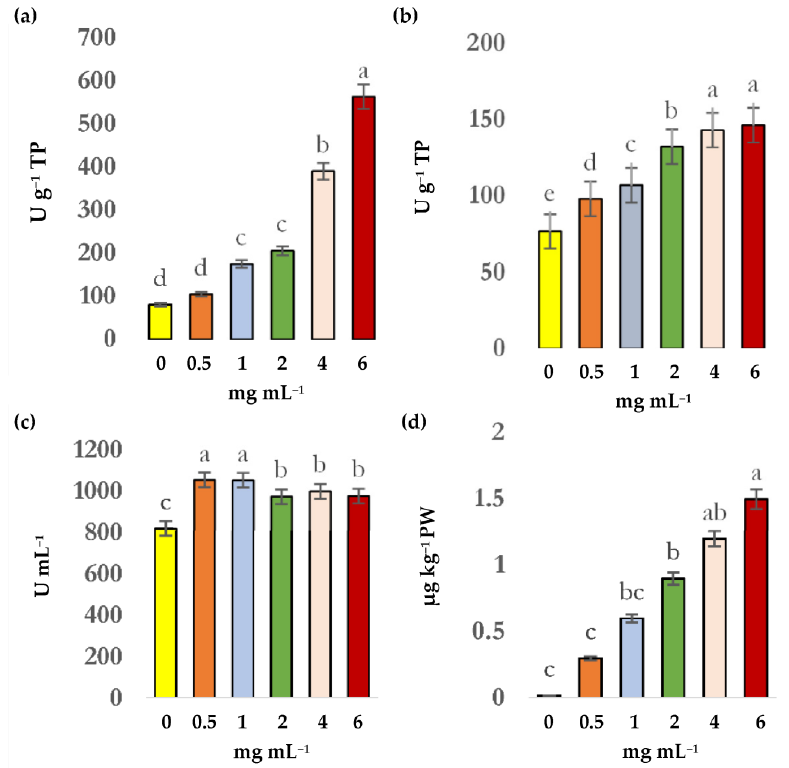
Figure 2. Content of glutathione peroxidase ( a ), catalase ( b ), superoxide dismutase ( c ), and copper ( d ) due to the effect of different doses of CuO-NPs applied in lettuce. Data shown as mean ± standard deviation (SD). Different letters indicate a significant difference ( p ≤ 0.05) according to Tukey´s test. U = unit (U); TP = total proteins; PW = dry weight.